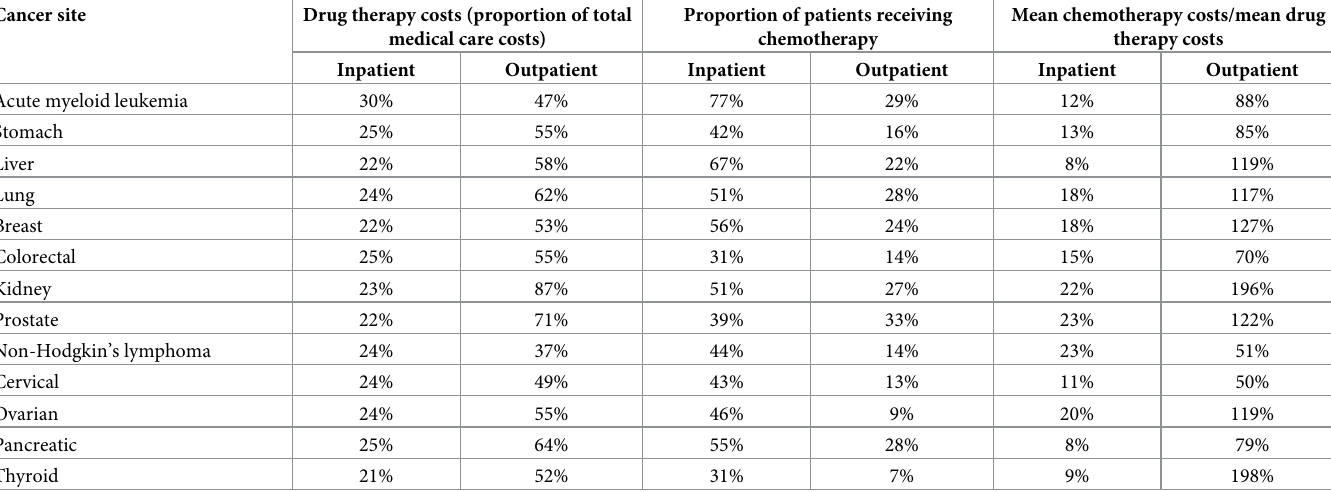
Table 4. Drug therapy costs, proportion of patients receiving chemotherapy, and chemotherapy to drug therapy cost ratio in the last month of life. Cancer site Drug therapy costs (proportion of total medical care